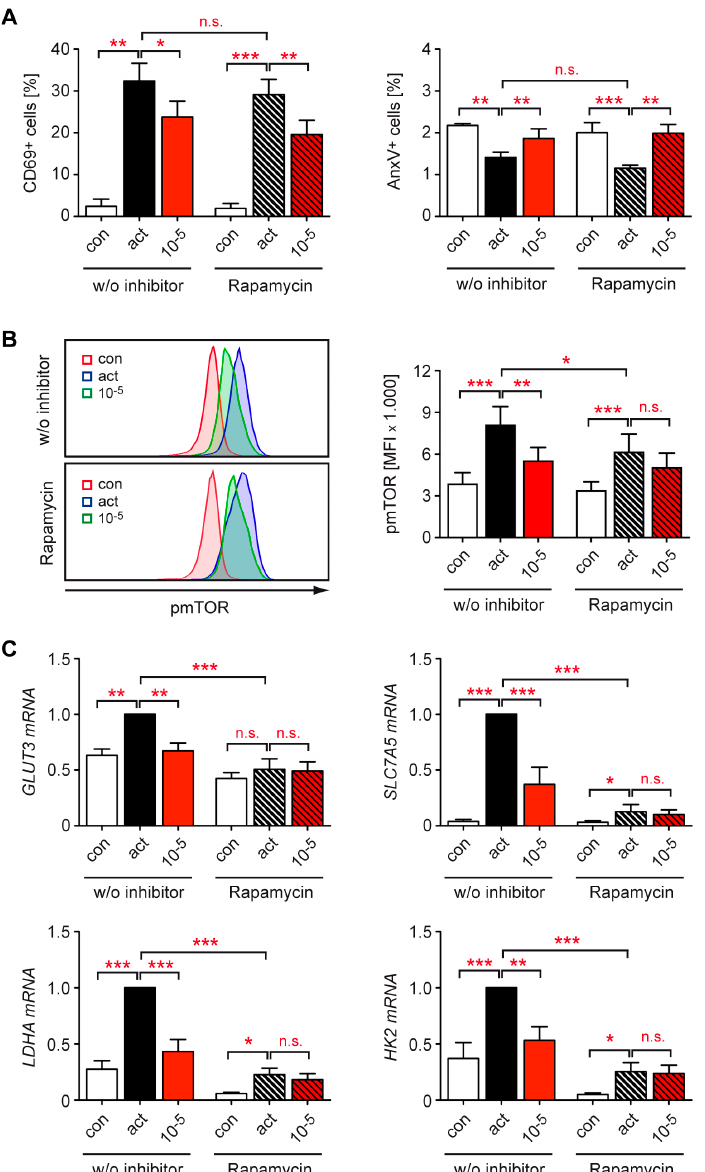
Figure 6. Role of mTOR signaling for the repressive activity of Dex on T cell function and metabolic gene expression in human peripheral blood T cells. ( A ) T cells were purified from buffy coats of healthy human donors and stimulated with hCD3 ε and hCD28 antibodies for 20 h in the absence (act) or presence of 10 − 5 M Dex. Unstimulated T cells served as a control (con). To study the role of mTOR, rapamycin was added at a concentration of 20 nM to the same experimental setup. The percentages of CD69 + and AnxV + CD3 + CD4 + T cells were determined by flow cytometric analysis. N = 9/3. ( B ) T cells were treated as in panel A. After extracellular staining for CD3, CD4, and CD69, the cells were fixed, permeabilized, and intracellularly stained for pmTOR (Ser2448). Analysis was performed by flow cytometry. Exemplary overlay histograms of pmTOR stainings of CD4 + T cells (con) or CD4 + CD69 + T cells (act, 10 − 5 M Dex) are depicted in the left panel. The mean fluorescence intensity (MFI) of pmTOR for CD4 + T cells (con) or CD4 + CD69 + T cells (act, 10 − 5 M Dex) is depicted in the right panel. N = 6. ( C ) Gene expression was determined by RT-qPCR. N = 7. Relative mRNA levels were calculated by normalization to the housekeeping gene 18SRNA . Expression in activated T cells was arbitrarily set to 1. Values are depicted as the mean ± SEM. Statistical analysis was performed by one-way ANOVA followed by a multiple comparisons test. Levels of significance: * p < 0.05; ** p < 0.01; *** p < 0.001; n.s., non-significant ( p >